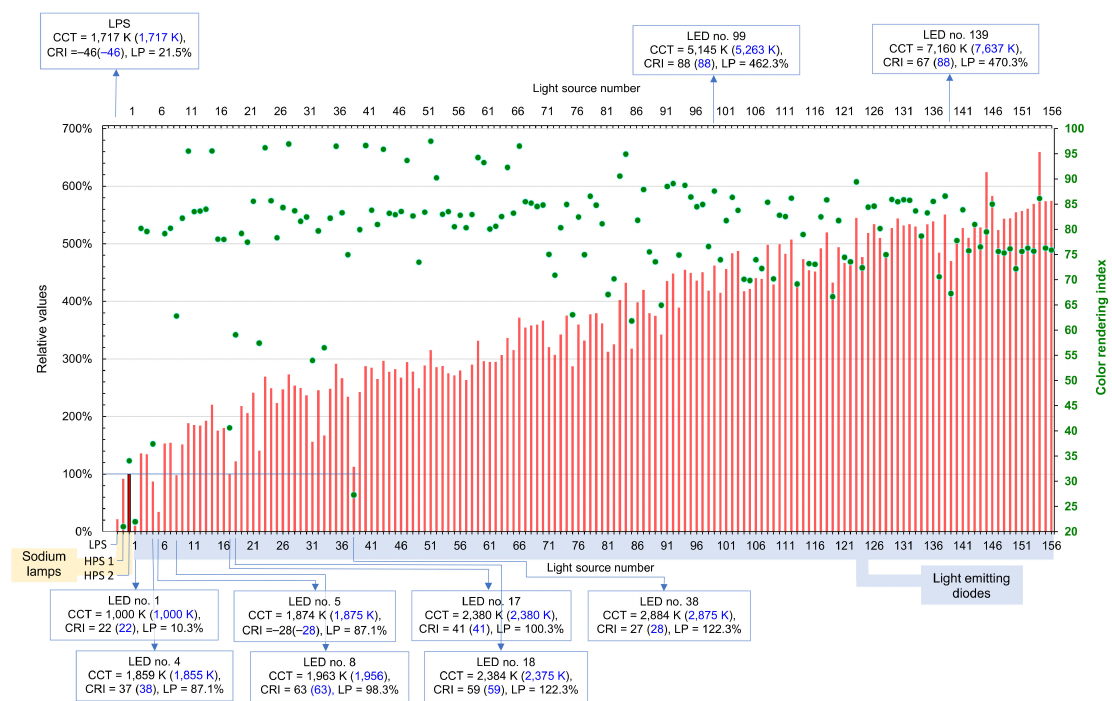
Figure 16. Graphical illustration of the impact on LP replacement of sodium lamps by LED sources with different CCT values, where the values of CCT and CRI shown in brackets concern the radiation emitted by the